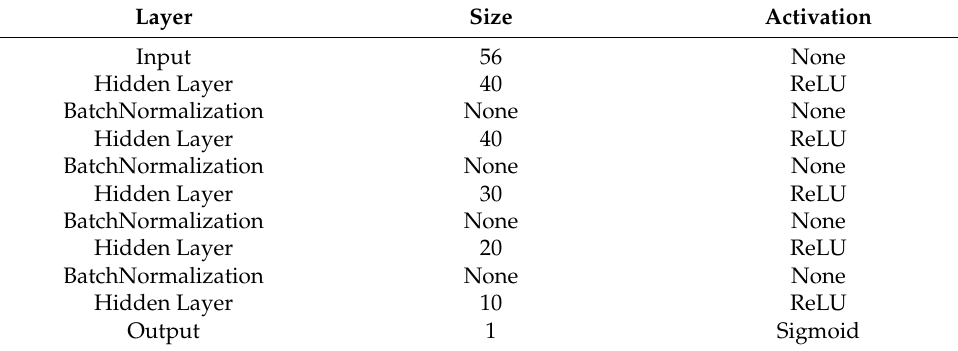
Table 3. Neural network model